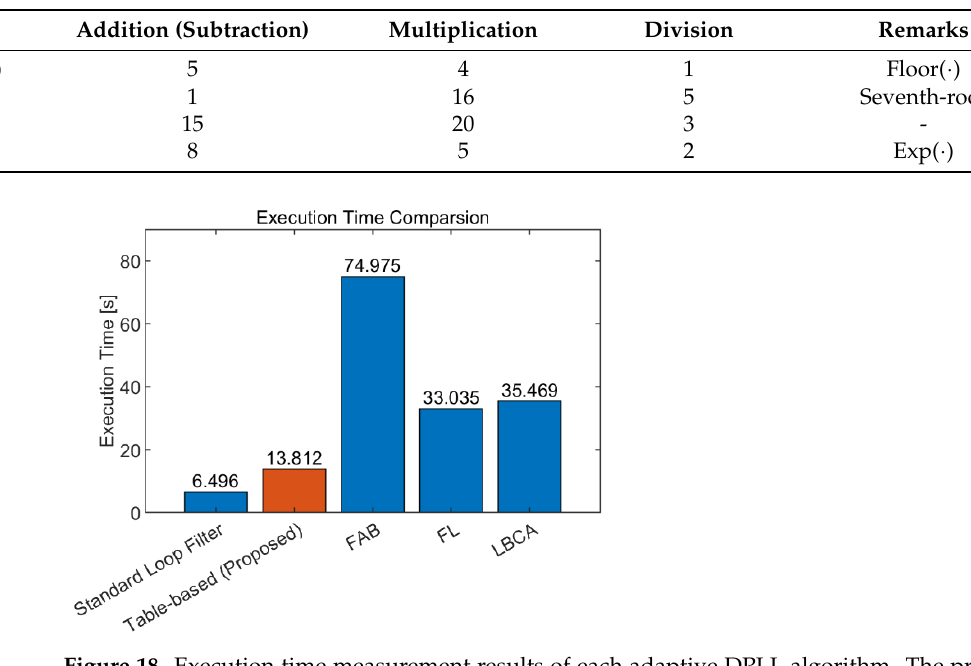
Figure 18. Execution time measurement results of each adaptive DPLL algorithm. The proposed algorithm has approximately 2.4–5.4 times faster execution time compared to the other adaptive DPLL